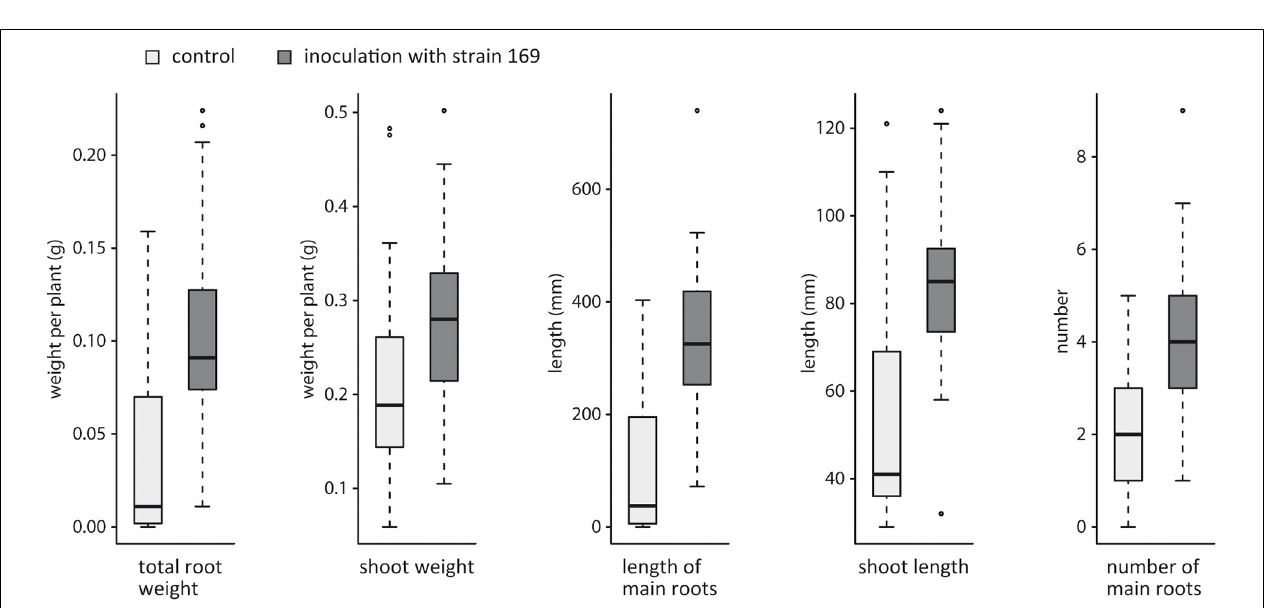
FIGURE 1 | Effect of Stenotrophomonas strain 169 on the performance of the in vitro poplar clone 741 in comparison to that of the uninoculated control 4 weeks after inoculation. Differences in root and shoot length as well as the number of roots are shown in the bar charts. Stars indicate significant differences ( p < 0.001, Wilcoxon rank sum test), vertical error bars display standard error.